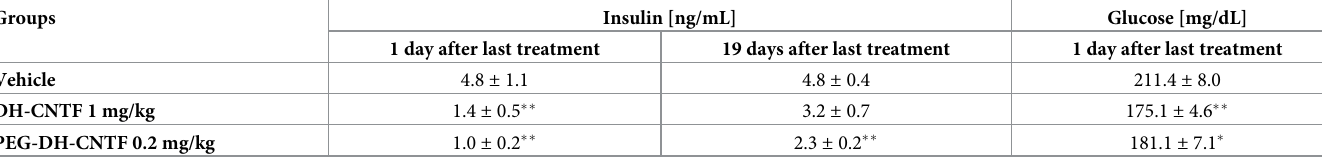
Table 3. Effect of DH-CNTF and PEGylated protein administration for 5 days on circulating insulin and blood glucose concentrations in DIO mice used for the weight loss and food intake study. Groups